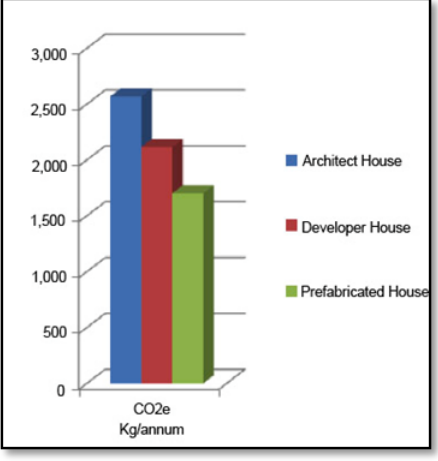
Figure 5: Energy consumption measured in kWha2